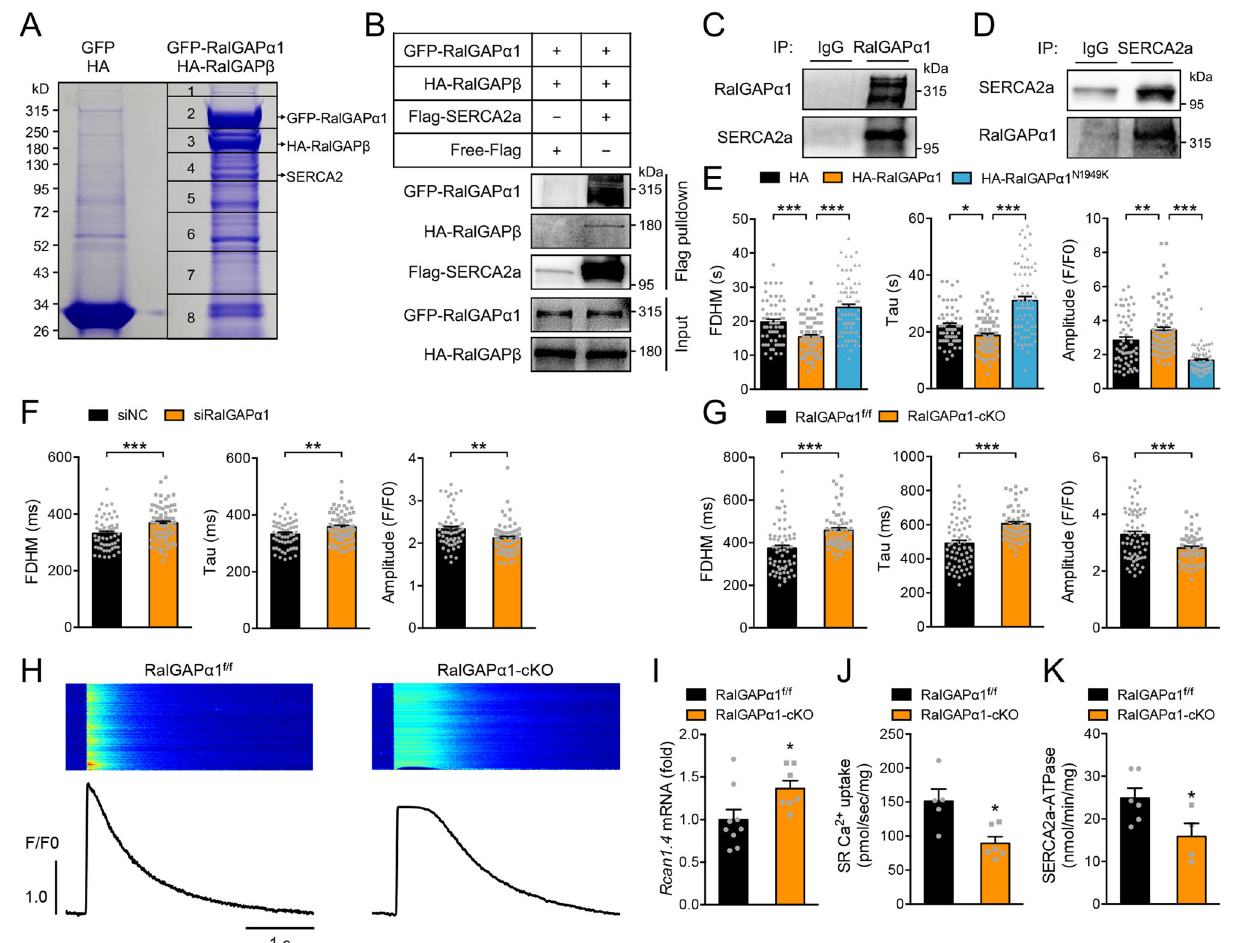
Fig. 3 | Identi fi cationofRalGAP α 1 asaregulatorofSERCA2a. A Identi fi cation of proteins associated with RalGAP α 1. GFP-RalGAP α 1 was expressed in HEK293 cells togetherwith HA-RalGAP β , and empty vectorswereexpressed in cells asa